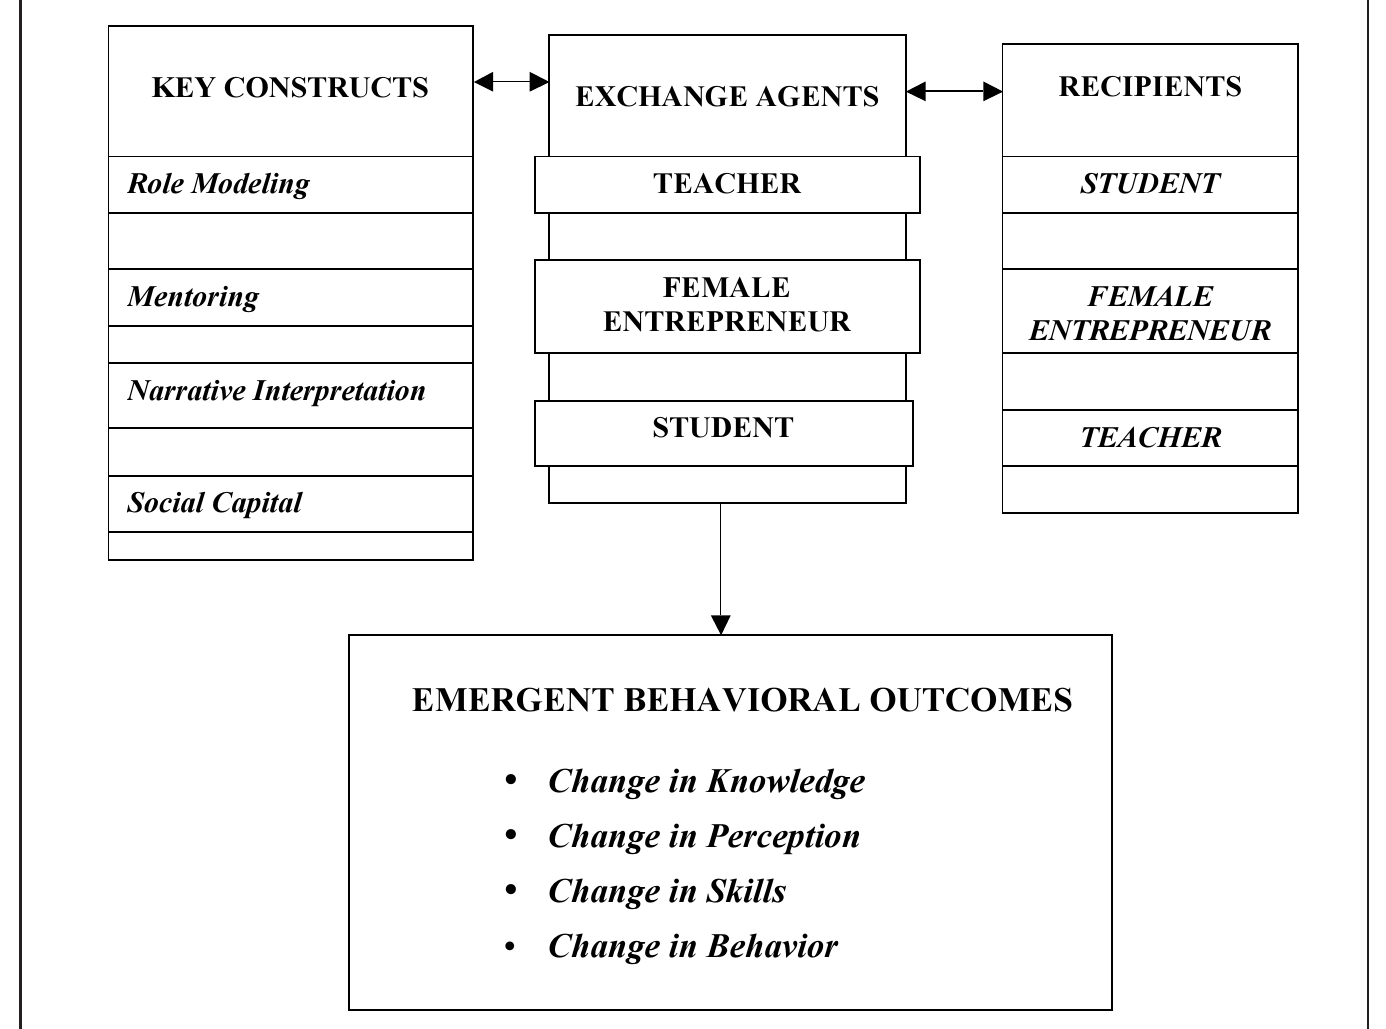
Figure 2. A Conceptual Model of Transformational Learning in Entrepreneurship